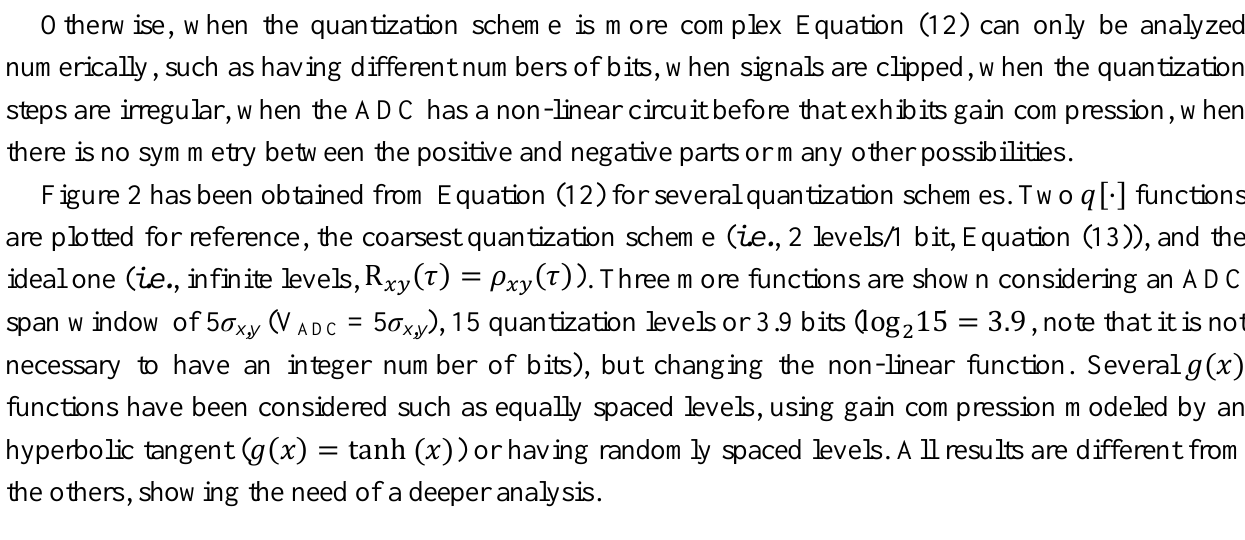
Figure 2. Relationship between the non-linear and the ideal correlation for different digitization